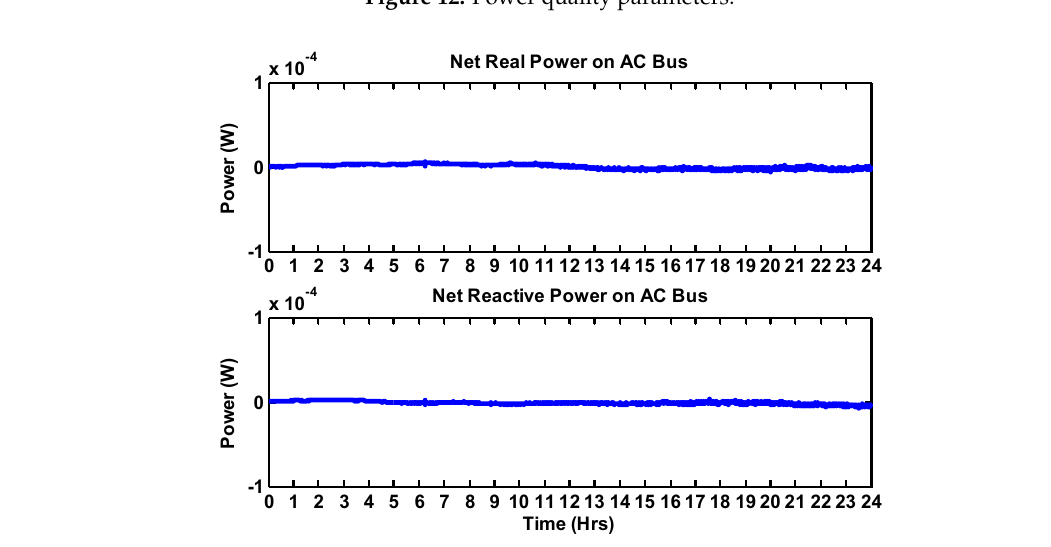
Figure 12. Power quality parameters.